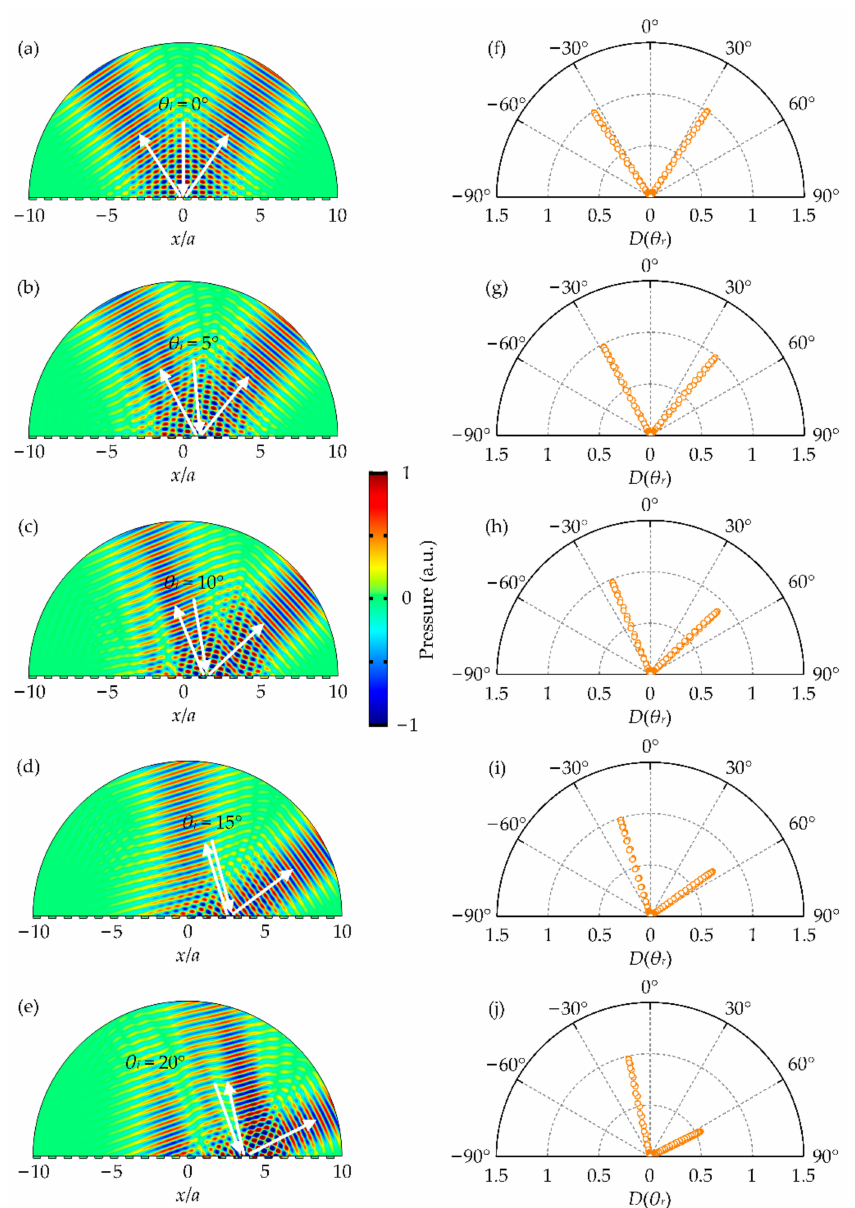
Figure 5. The case of a = 1.8 λ 0 . The scattering pressure field distributions for the beam splitting with the incident angle of ( a ) θ i = 0 ◦ , ( b ) θ i = 5 ◦ , ( c ) θ i = 10 ◦ ( d ) θ i = 15 ◦ , and ( e ) θ i = 20 ◦ . The white arrows show the directions of the incident and the reflected waves. The polar plots of the normalized intensity of the scattering waves in the exterior field with the incident angle of ( f ) θ i = 0 ◦ , ( g ) θ i = 5 ◦ , ( h ) θ i = 10 ◦ , ( i ) θ i = 15 ◦ , and ( j ) θ i = 20 ◦ . The lateral axes in ( f – j ) are the normalized ) . All the intensities are normalized to the maximal intensity of the scattering intensity defined as D ( θ r waves of the normal